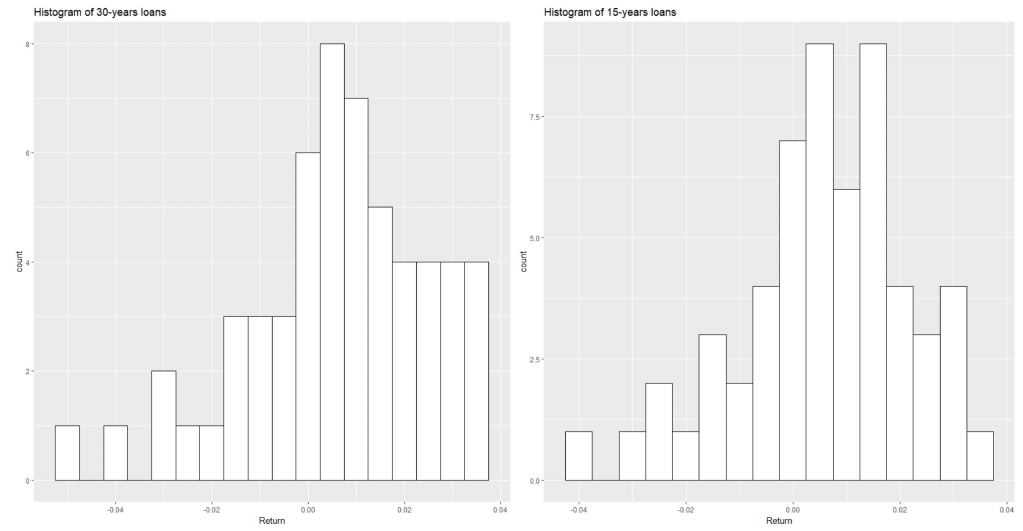
Figure 6. Histogram of t -year of